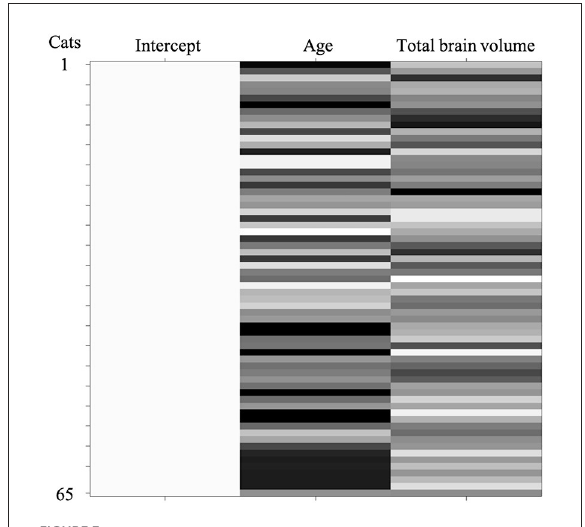
FIGURE3 Design matrix of the regional analysis corrected by total brain volume in SPM12 to evaluate aging changes in gray and white matter atrophy. A total number of cats in each condition is displayed along the ordinate and variables are represented in the abscissa. Three columns model the effects of intercept, age, and total brain volume. Age and total brain volume were used as a covariate. Values of each variable (columns) for each cat (rows) are represented by a grayscale color